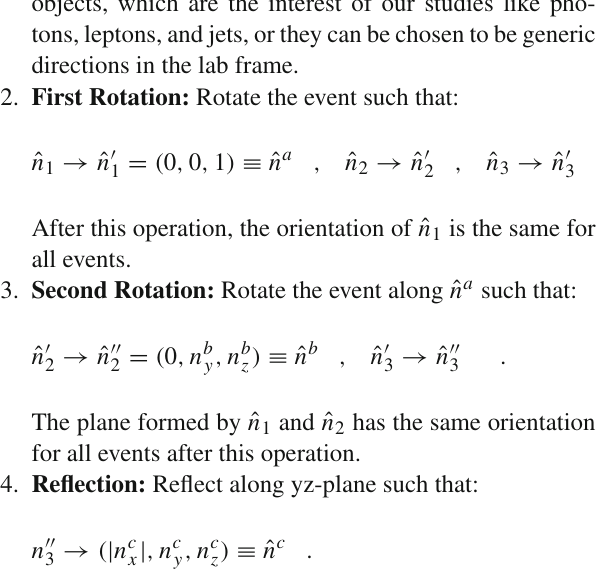
η C ’s. We vary C uniformly in